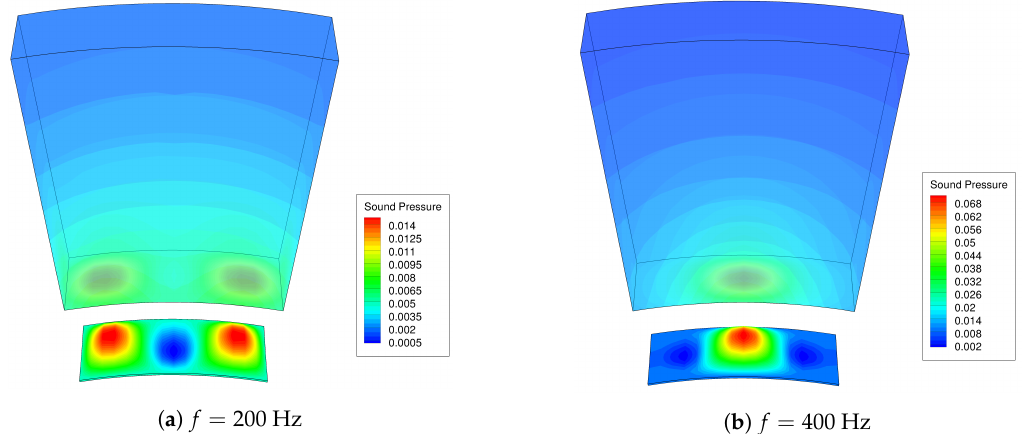
Figure 6. Cylindrical panel with simply-supported boundary-conditions. 3D-view of the Sound Pressure (Pa) evaluated at different frequencies from the top surface to a radial distance of 0.5